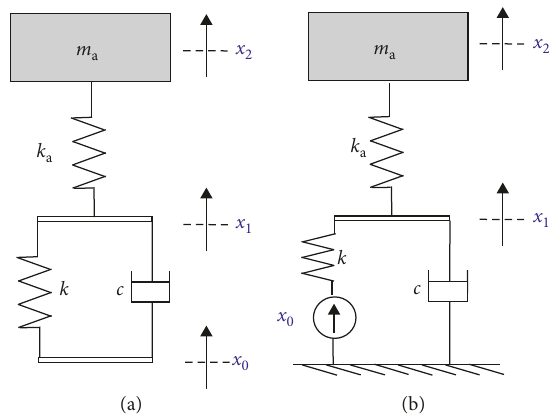
Figure 13: Two design cases: (a) k